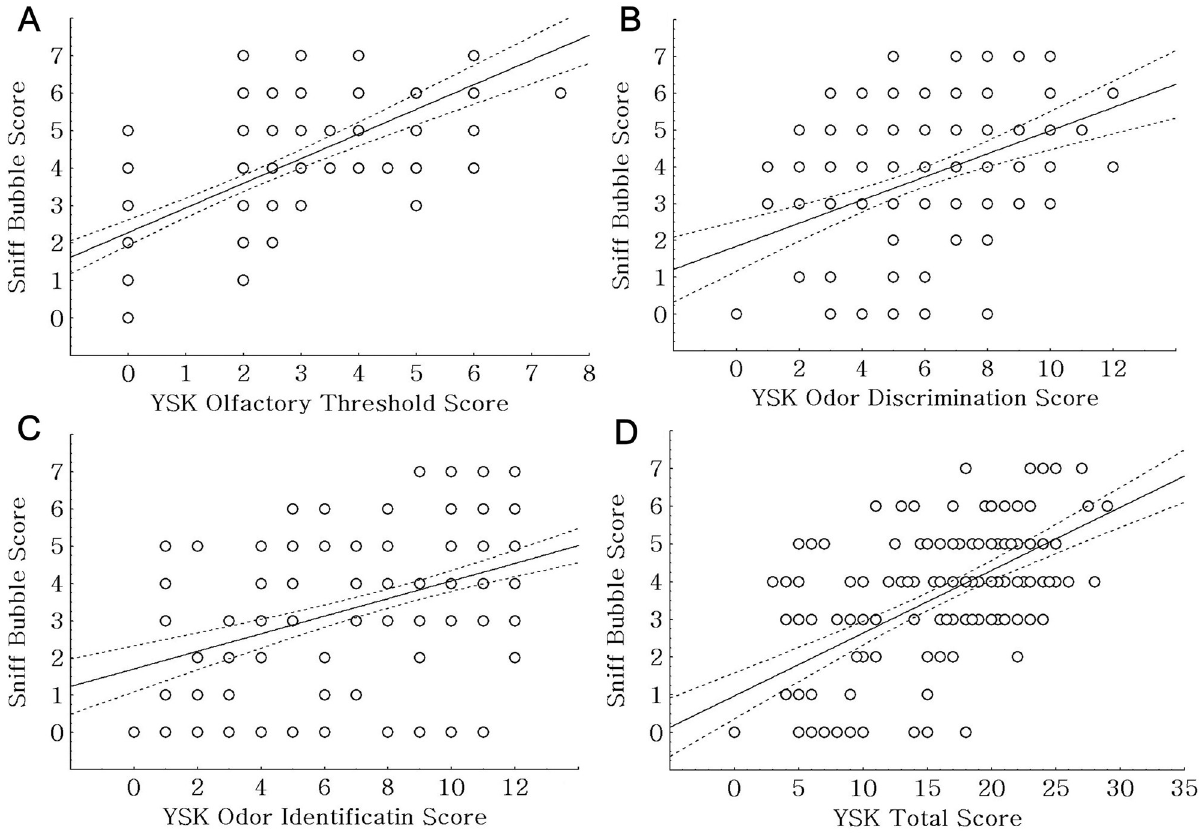
Fig 2. Analyses of the correlation between the Sniff Bubble and YSK olfactory function test scores. (A) There was a positive correlation between Sniff Bubble and YSK olfactory threshold test scores ( r = 0.646, p < 0.001). (B) There was a positive correlation between Sniff Bubble and YSK odor discrimination test scores ( r = 0.414, p < 0.001). (C) There was a positive correlation between Sniff Bubble and YSK odor identification test scores ( r = 0.477, p < 0.001). (D) There was a positive correlation between Sniff Bubble and YSK olfactory function test total scores ( r = 0.597, p < 0.001).